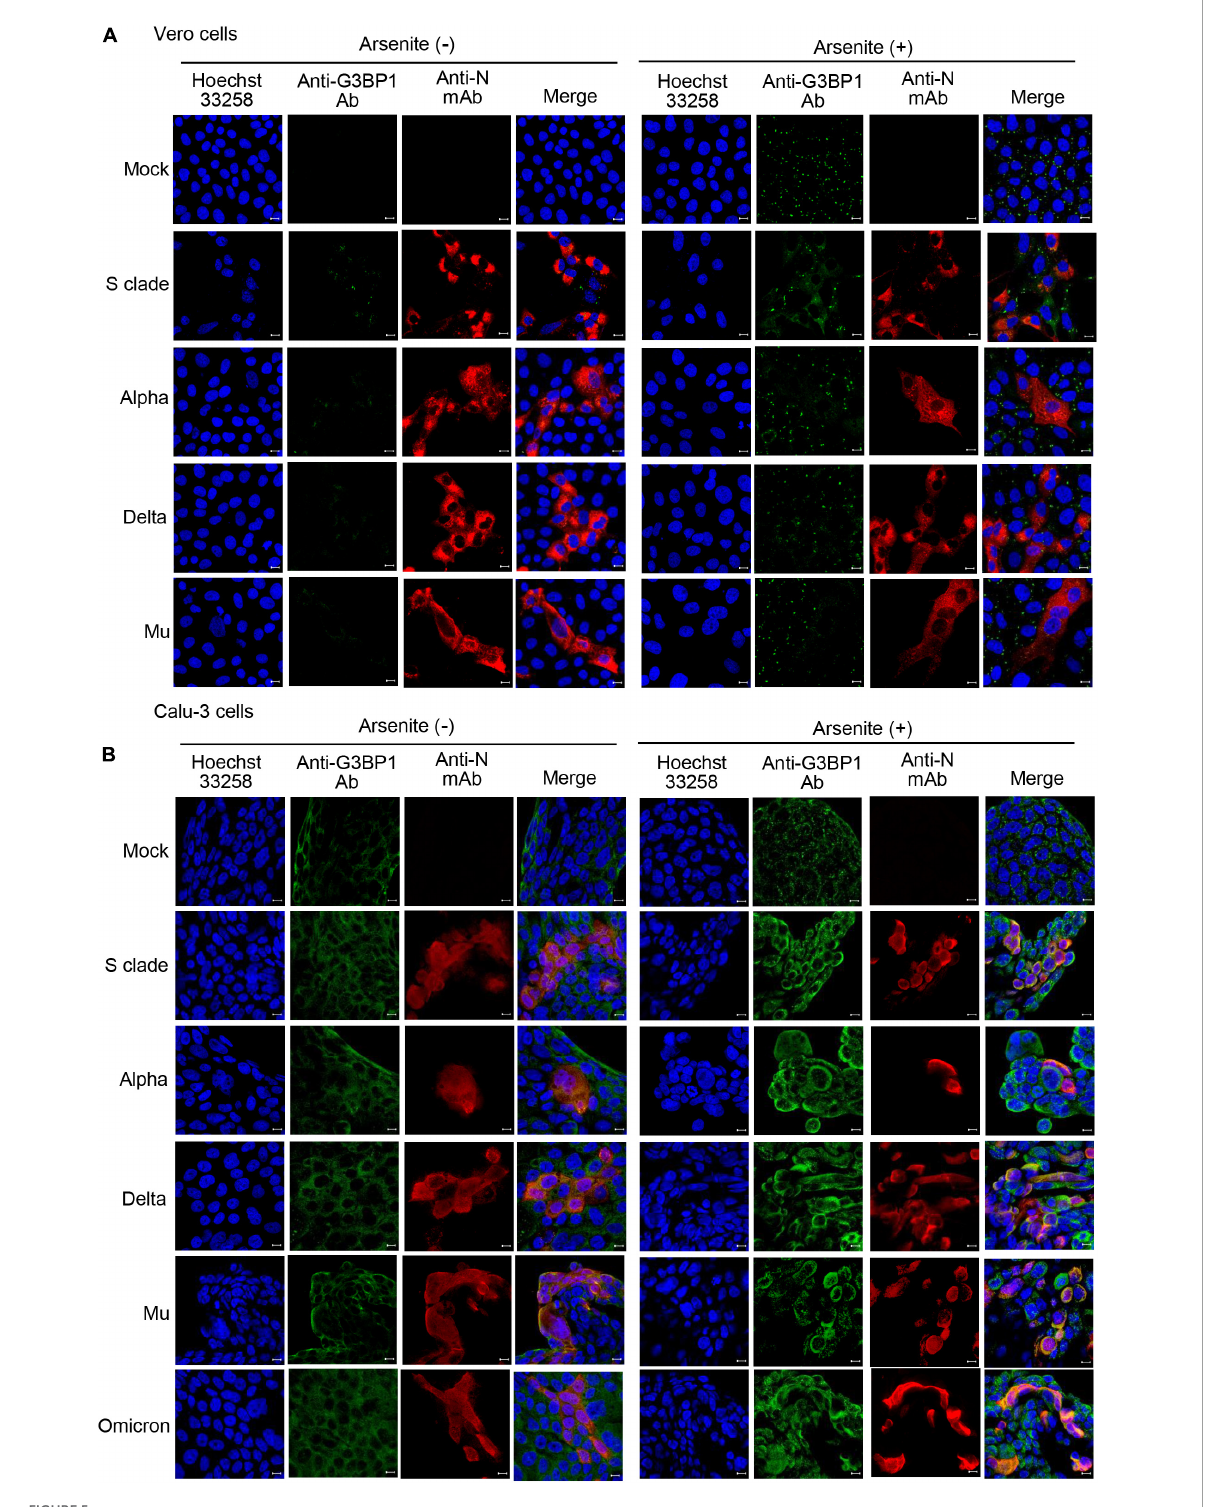
FIGURE5 Detection of stress granules in cells infected with different SARS-CoV-2 variants. Vero cells (A) and Calu-3 cells (B) were mock-infected or infected with SARS-CoV-2 variants at 0.1 MOI for 71 h and analyzed by immunofluorescence confocal microscopy. Cells were treated with PBS or 0.5 mM sodium arsenite for 1 h, prior to fixing and staining with anti-GRBP1 antibody (green) and anti-SARS-CoV-2 N mAb (red). Nuclei were stained Hoechst 33258 (blue). Anti-N Ab, anti-SARS-CoV-2 N mAb (clone 1G10C4